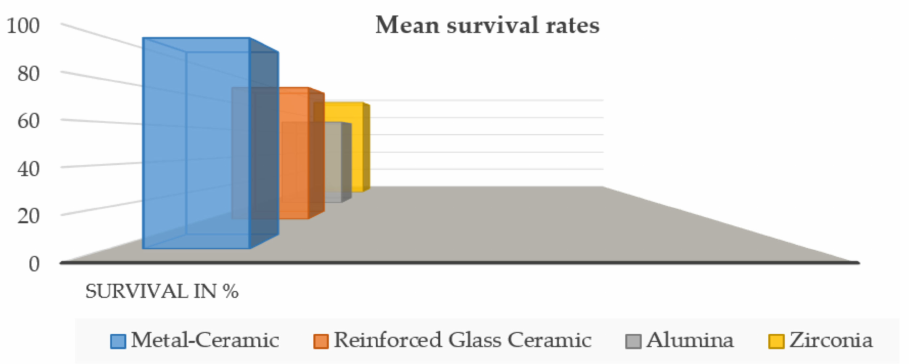
Figure 5. Mean survival rates after 5